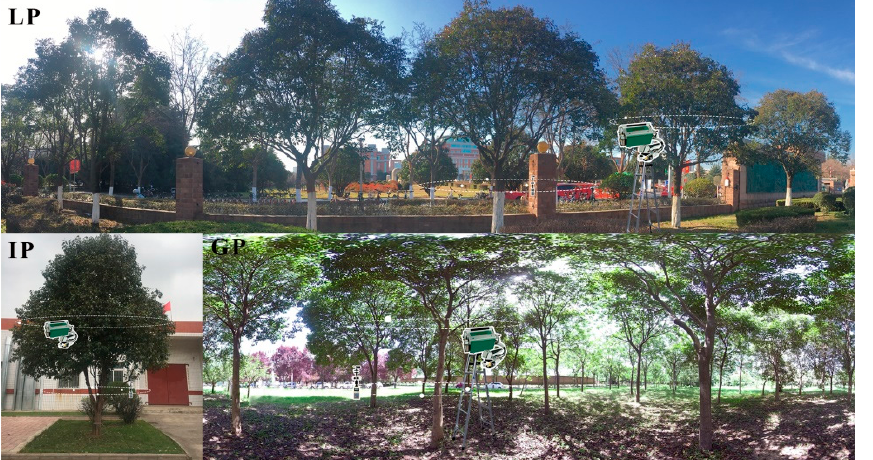
Figure 2. A live view of three configuration modes (take Ligustrum lucidum as an example). IP-Isolated Planting; LP-Linear Planting; GP-Group Planting.